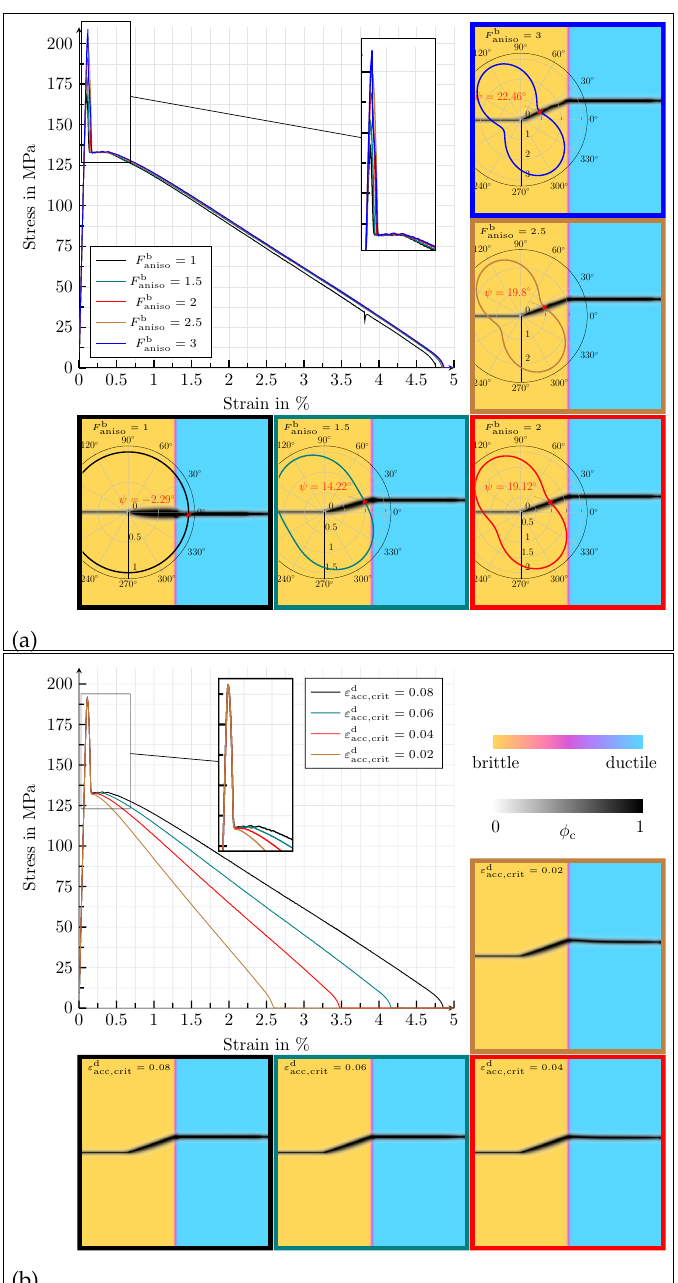
Figure 4. ( a ) Homogenised macroscopic stress–strain responses in the case of uniaxial tension for = different values of F b 1,1.5,2,2.5,3 , for the simulation setup with a planar diffuse interface aniso { } between two solid phases. The contour plots of the crack phase φ c at fracture, overlaying the solid phases, for the different values of F b are given below and beneath the stress–strain diagram. aniso ( b ) Homogenised macroscopic stress–strain responses in the case of uniaxial tension for different = values of ε d 0.08,0.06,0.04,0.02 , for the simulation setup with a planar diffuse interface acc,crit { } between two solid phases. The contour plots of the crack phase φ c at fracture, overlaying the solid phases, for the different values of ε d are given below and beneath the stress–strain acc,crit